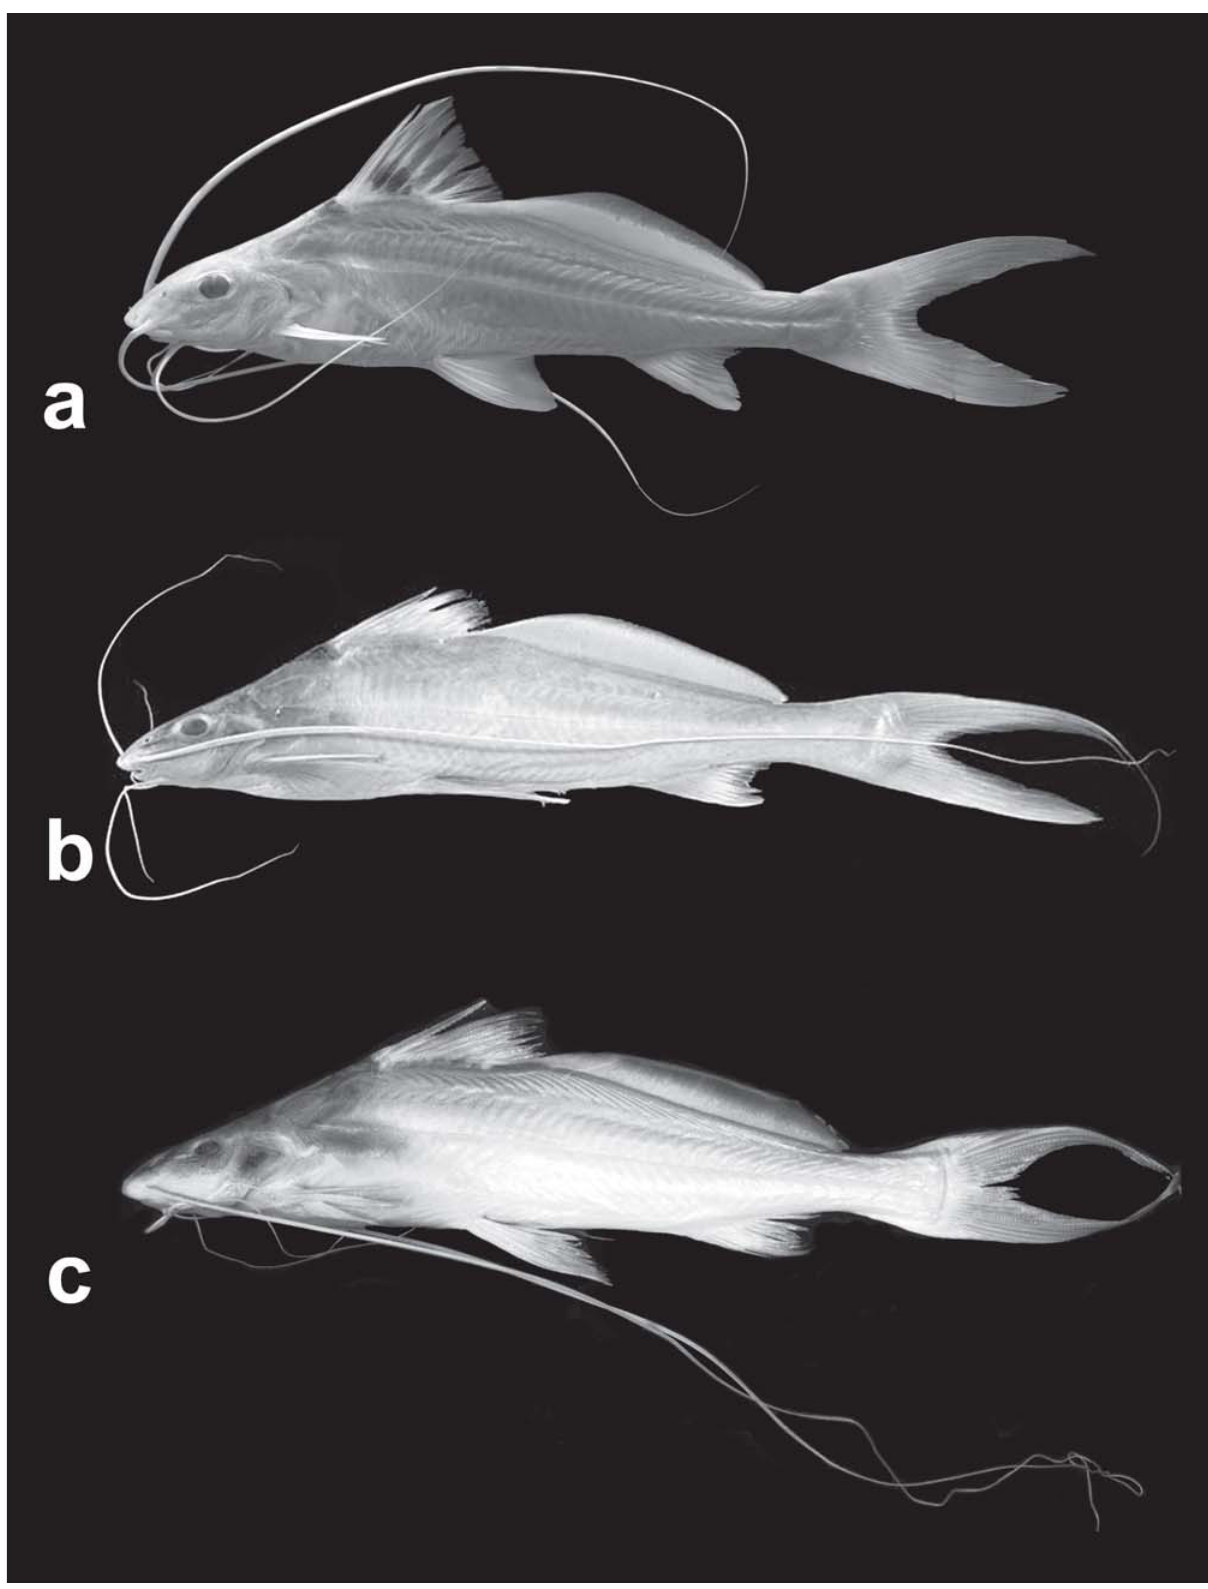
Fig. 2. a, Propimelodus araguayae , INPA 26121, paratype, 130.6 mm SL; b, P. caesius , MZUSP 88582, holotype; c, P. eigenmanni , FMNH 110975. Photos of P. caesius from Parisi et al . 2006 and P. eigenmanni from Lundberg & Parisi, 2002. Photo of P. araguayae by L. M.